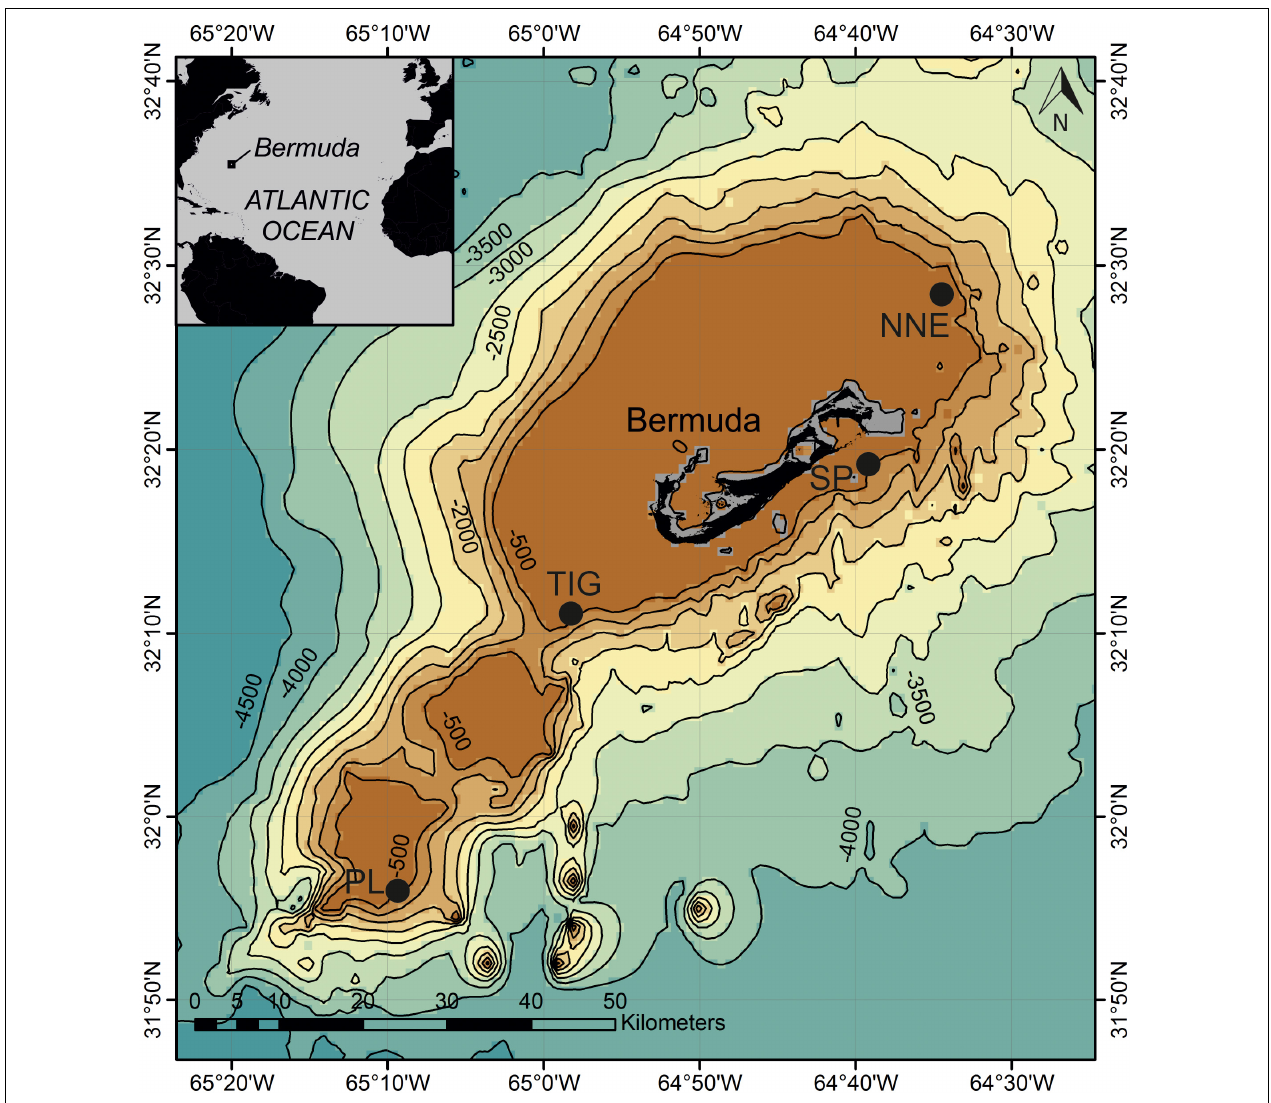
FIGURE 1 | Map of study sites around Bermuda. Data overlay GEBCO_2014 Grid which provides 30 arc-second global grid of elevations. Depth contours in meters. NNE, North Northeast; PL, Plantagenet Bank; SP, Spittal; TIG, Tiger.